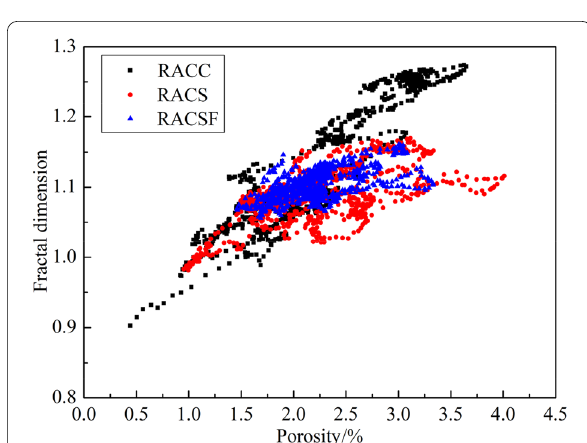
Fig. 10 Influence of admixtures on the fractal dimension of pores Fig. 11 Influence of curing system on the fractal dimension of